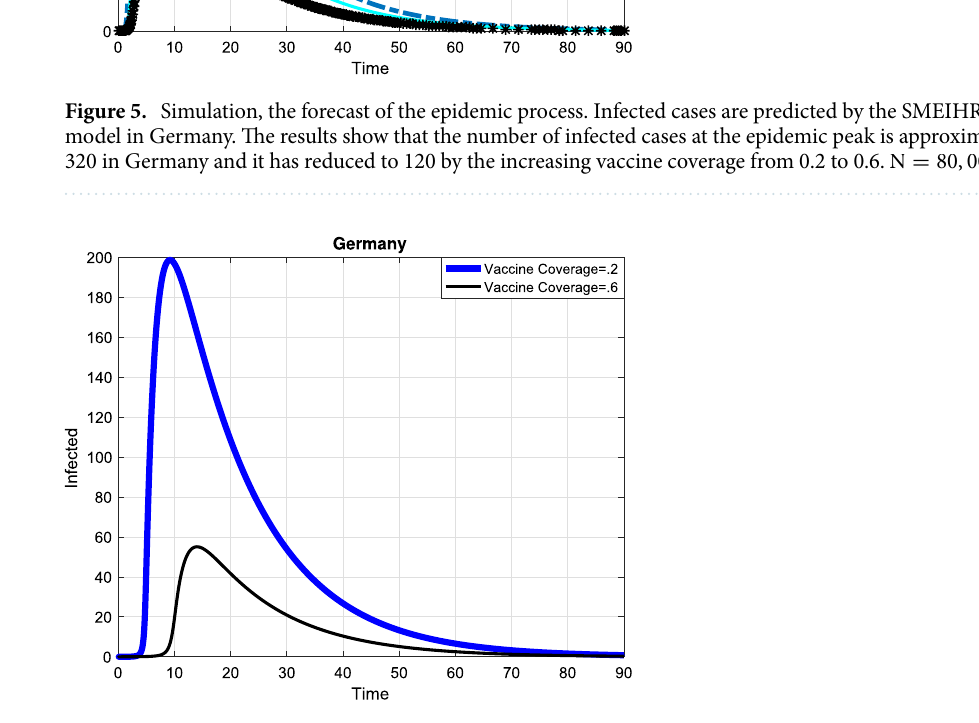
Figure 6. Simulation, the forecast of the epidemic process. The forecast of the epidemic growing tendency for infected cases through the SMEIHRDV model with the best investment strategy in social distancing. The results show that the best investment strategy in social distancing reduces the epidemic peak for infected cases and also by increasing the vaccine coverage, the epidemic peak for infected cases decreases. The number of infected cases at the epidemic peak is approximately 200 in Germany and it has reduced to 55 by the increasing vaccine coverage from 0.2 to 0.6. N = 80, 000,